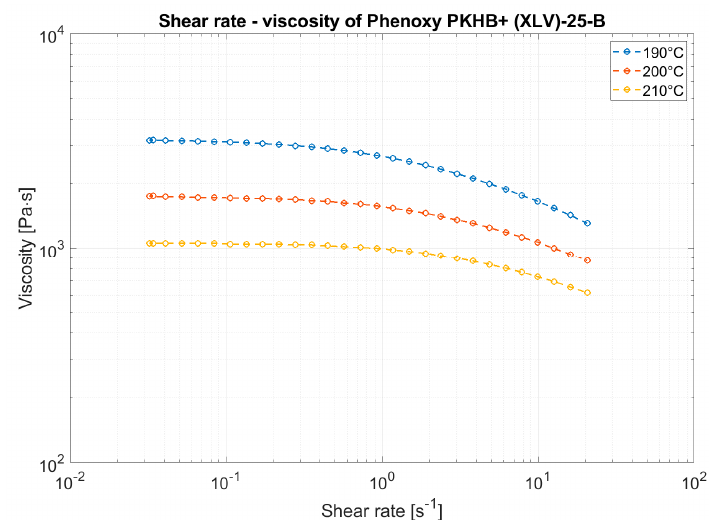
Figure 5. Viscosity behavior measured with a plate-to-plate rheometer.